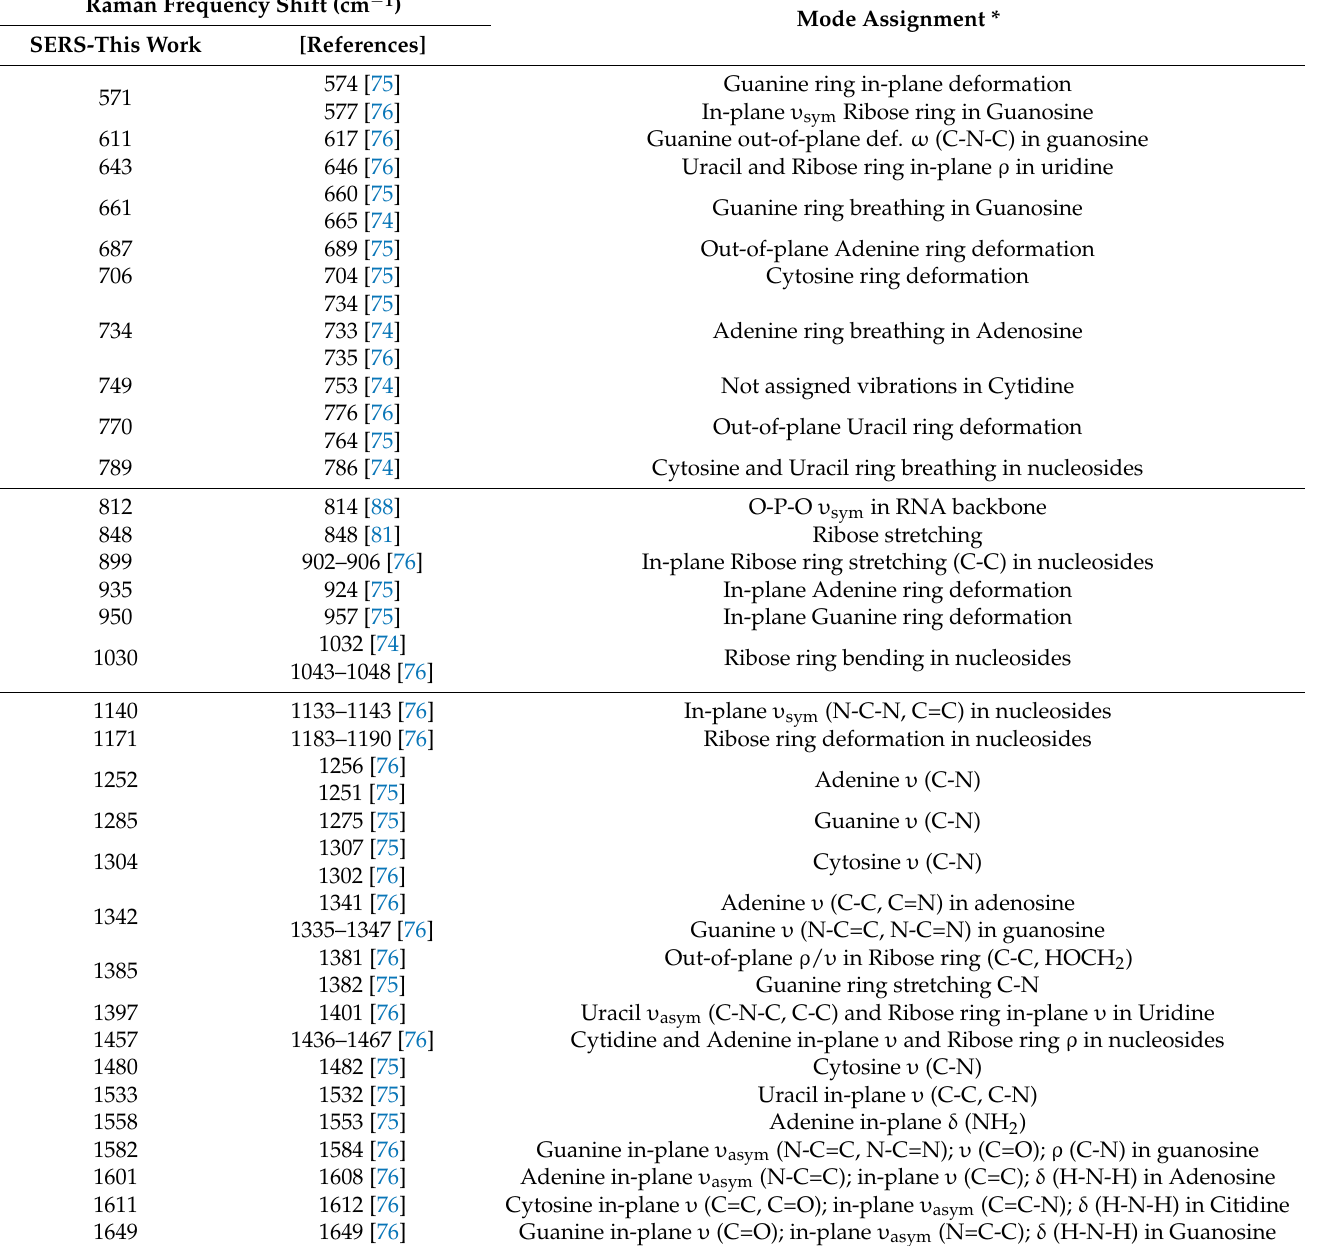
Table 1. Detailed identification of each Raman mode in comparison with the literature and